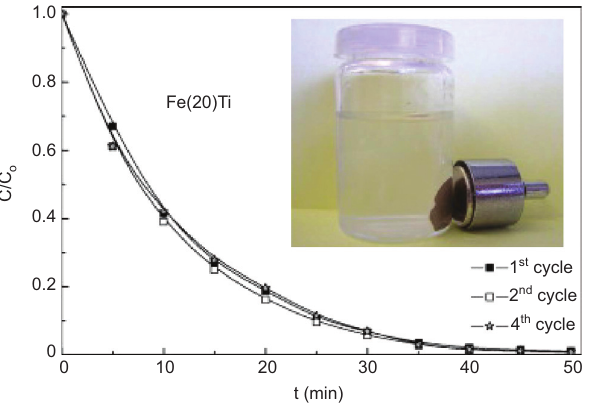
Figure 14 Degradation of propachlor with recycled Fe(20)Ti catalyst after successive cycles. Inset: Illustration of the magnetic separation of the Fe(20)Ti photo- catalyst from the liquid media. Reprinted from Ref. [102]. © 2009 With permission from